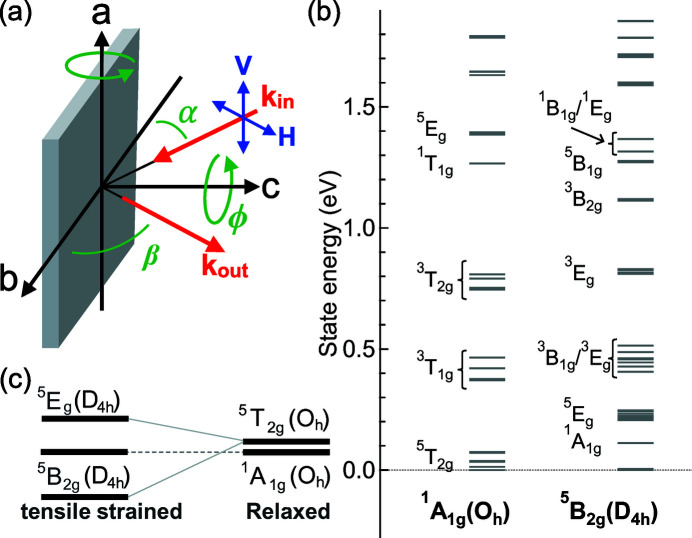
(a) Illustration of the geometry and the angles. (b) Energy diagram for the 1A1g(Oh) ground state and the 5B2g(D4h) ground state. (c) The 5B2g(D4h) state is the split subgroup of the 5T2g(Oh) state in the tetragonal distortion (in-plane tensile strained) (Wang et al., 2019 ▸).